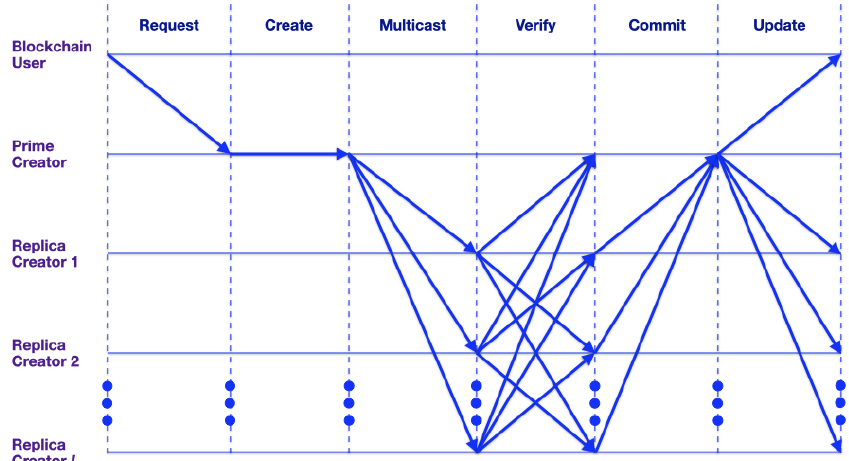
Figure 6. The blockchain operations in the federated egg banking blockchain